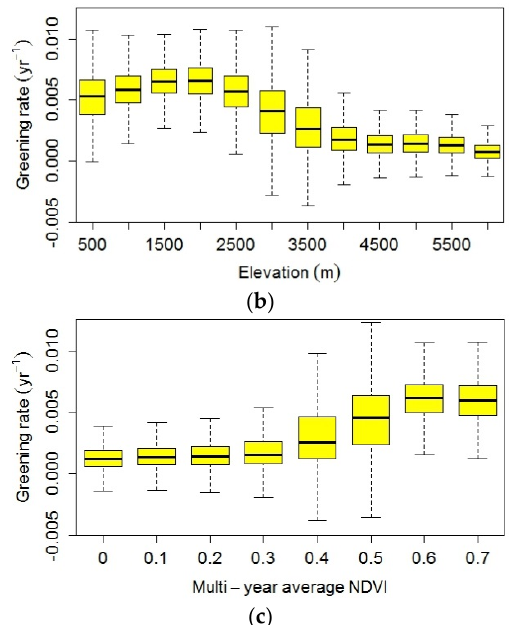
Figure 4. Elevation-dependent pattern of multi-year average NDVI ( a ) and greening rate ( b ), and the relationship between greening rate and multiyear average NDVI ( c ) in the YZR basin during 1999–2013. The box-and-whisker plot is produced from the 25th to 75th percentiles at the ends of the box, the median is indicated with a horizontal line in the interior of the box, and the maximum and minimum are at the ends of the whiskers.